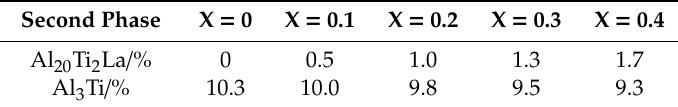
Table 2. Area ratio of Al 20 Ti 2 La and Al 3 Ti in the Al-TiO 2 -C-XLa 2 O 3 refiner.